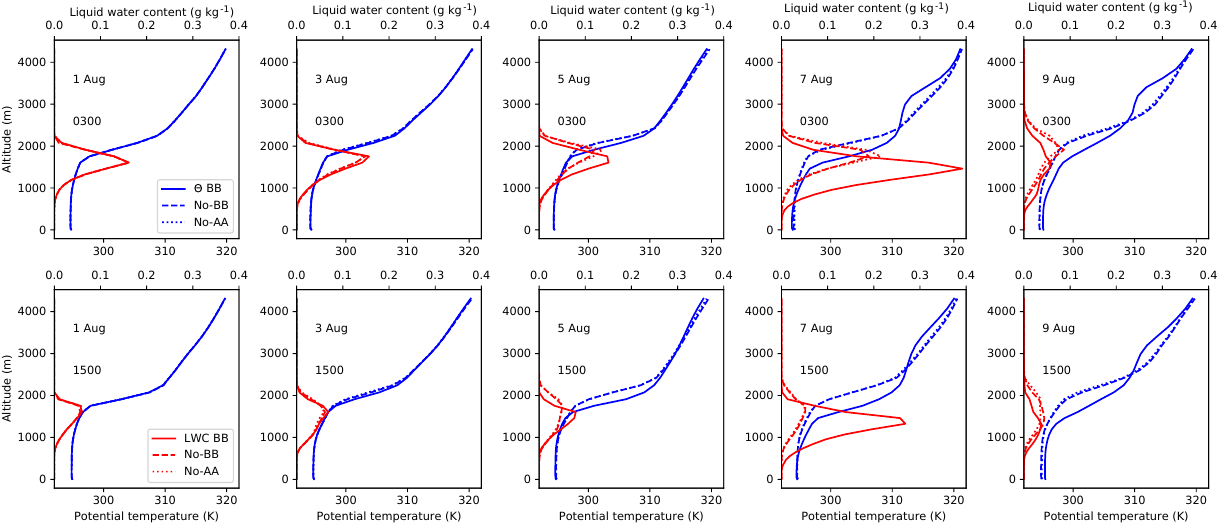
Figure 13. Domain-mean vertical profiles of potential temperature (cid:50) and liquid water content (LWC) in the regional model with and without biomass burning aerosol on odd-numbered days at the times of day marked.